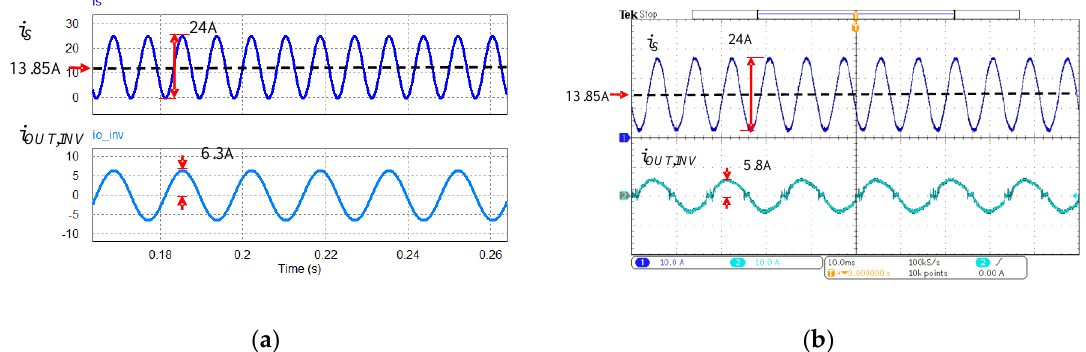
Figure 12. The output currents of the distributed energy source before the ARF was integrated: ( a ) Simulation result and ( b ) experimental result.